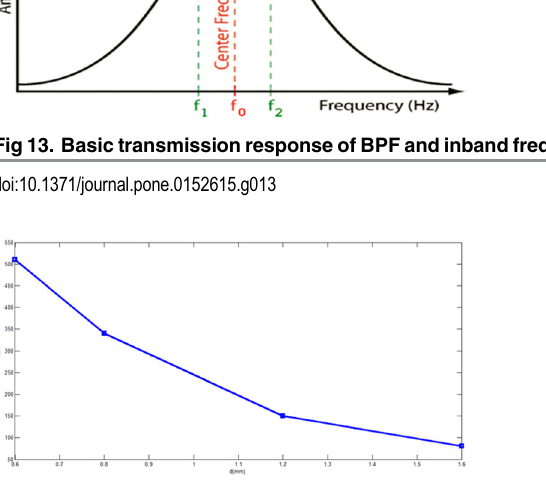
Fig 14. External quality factor Qex as function of d.